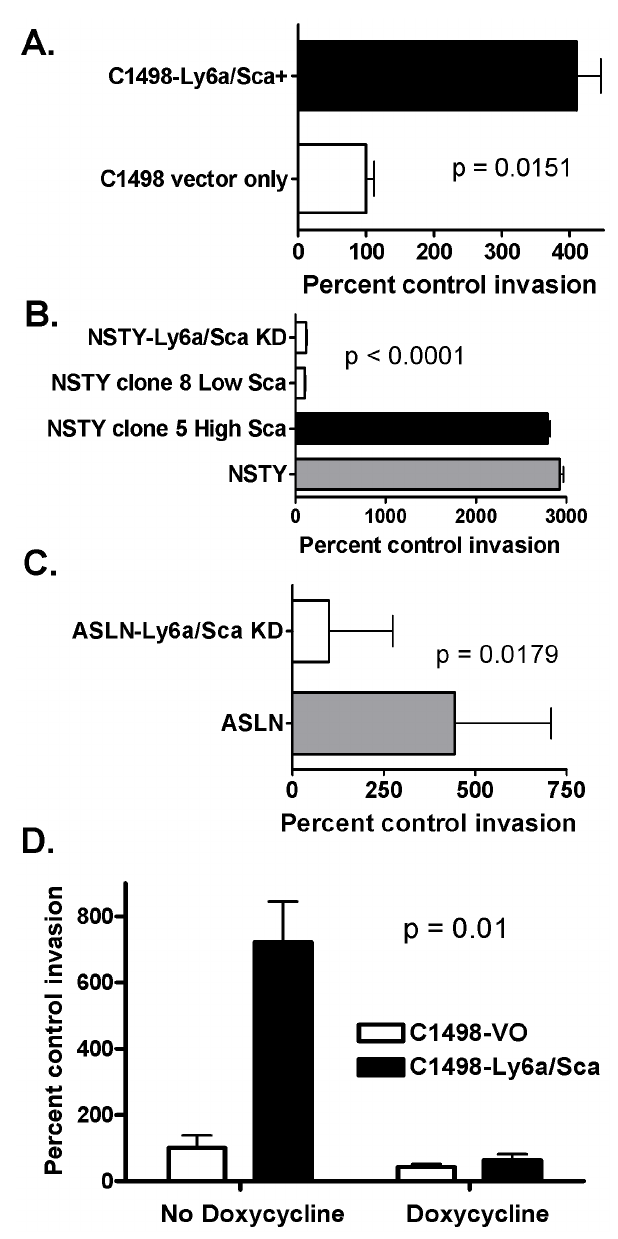
Figure 7. Leukemia cells with higher levels of Ly6a/Sca-1 expression exhibit greater invasiveness in Matrigel assays. In each assay the invasion of leukemia cells in the experimental group with higher levels of Ly6a/Sca-1 is expressed as percent relative to number of invading cells in the control group with low levels of Ly6a/ Sca-1 expression. The control is represented as 100%. Averages and sem are displayed. (A) ‘‘C1498-Ly6a/Sca + ’’ is C1498-Ly6a/Sca-1 compared to C1498-vector only. P0.0151 by t-test. N3 per group. (B) ‘‘NSTY’’ is